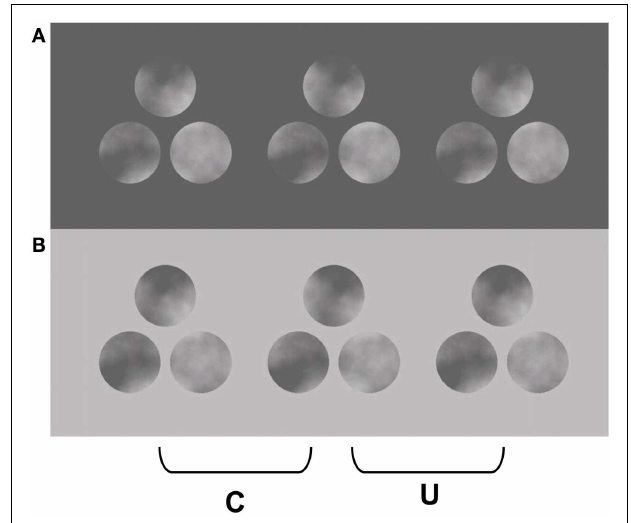
FIGURE 2 |Two-dimensional noise analogues of the stereo images presented in Figure 1. When the two left panels are cross fused or the two right panels divergently fused, the texture appears to split into two layers: dark clouds over light disks in (A) , and light clouds over dark disks in (B) . Note that the lightest regions within the texture on the dark surround appear as portions of a far surface in plain view, and similarly for the darkest regions of the texture on the light surround. Adapted from Anderson (1999), with